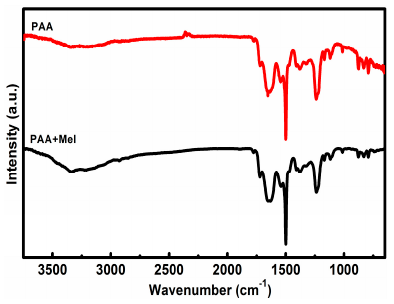
Figure 1. ATR-FTIR spectra of polyacrylic acid (PAA) and modified polyacrylic acid (MPAA).